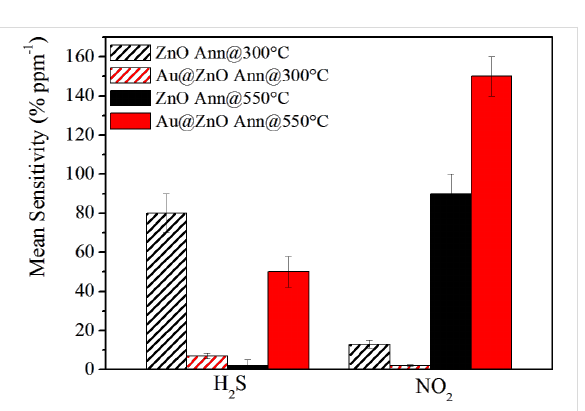
Figure 7: Mean sensitivity of pristine and Au@ZnO annealed at 300 and 550 °C towards H 2 S and NO 2 gases at an operating temperature of 300